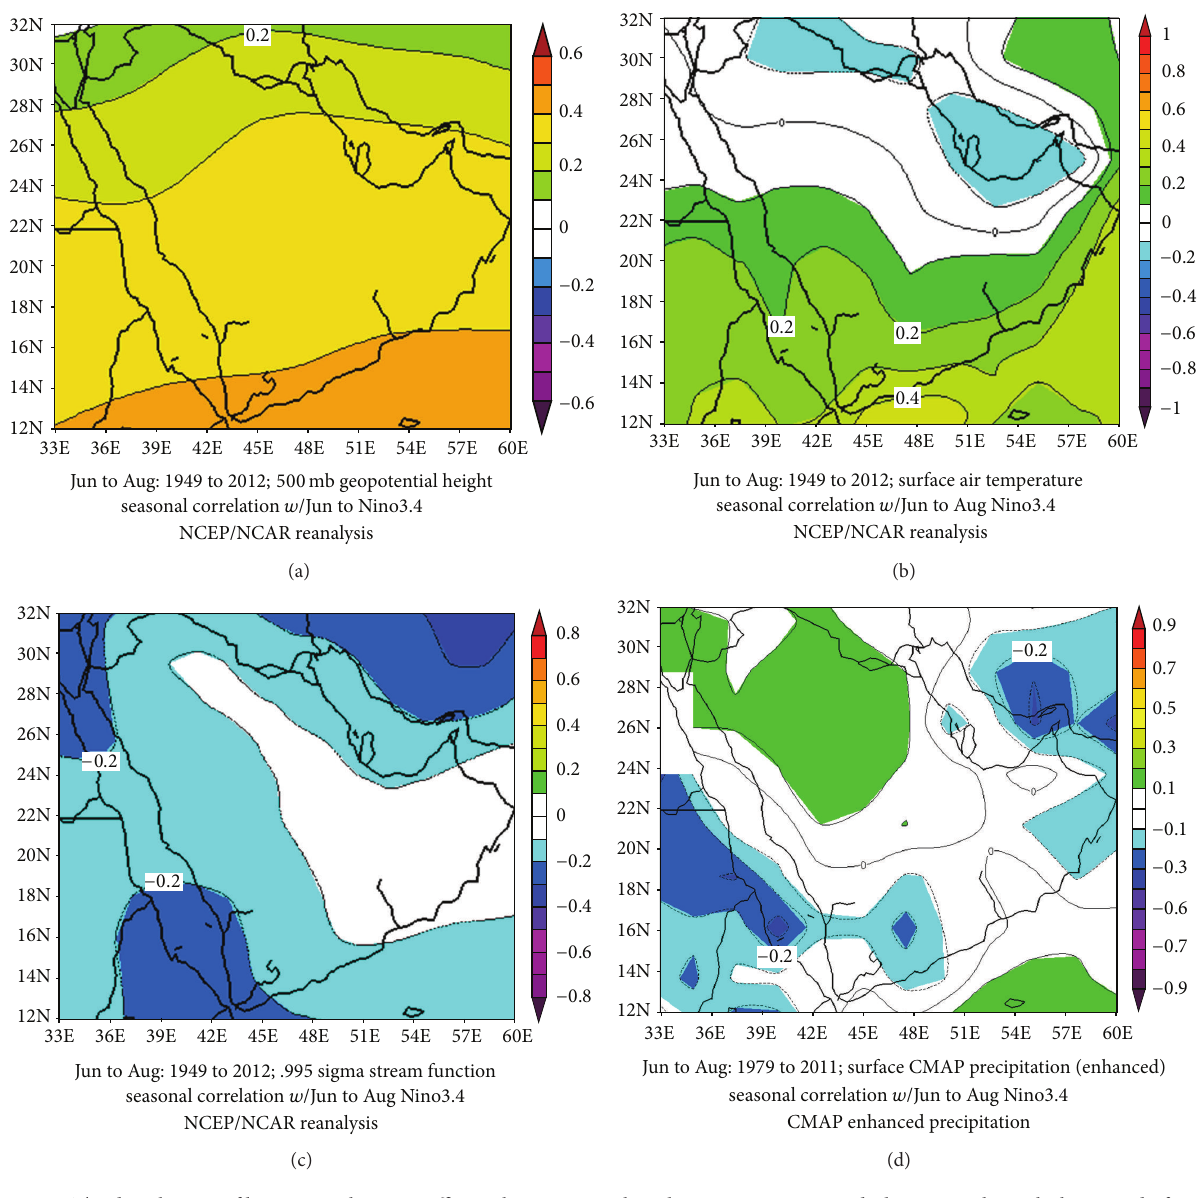
[+0.38, +0.39, +0.33 and +0.45] between the surface wind speed, outgoing long wave radiation, precipitation rate, and relative humidity over KSA and SOI,